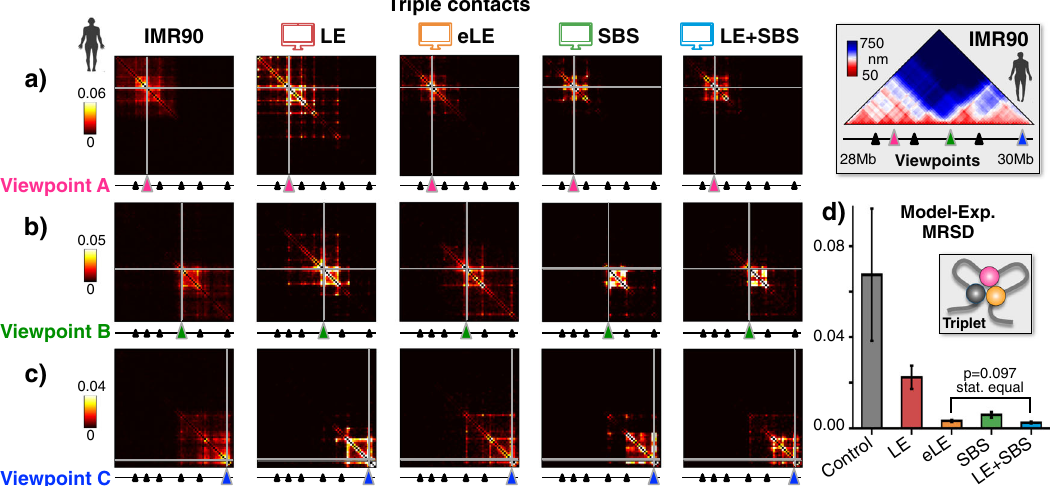
Fig. 4 Triple contact data are well described by the models, especially by the eLE and the LE + SBS. Triple contact probability maps are shown in microscopy data 6 (left) and in the models from three different viewpoints a , b , c , more viewpoints in Supplementary Fig. 19. d The mean relative squared difference (MRSD) between imaging and model triplet contact maps is the lowest in the LE + SBS model, which is statistically equivalent to the eLE model (two-sided Welch ’ s t -test p = 0.097). The control is made of randomly folded self-avoiding polymer chains with same number of beads and size than the experimental structures. Error bars represent SEM. n = 1000 independent single-molecule conformations for each model. Source data are provided as a Source Data fi